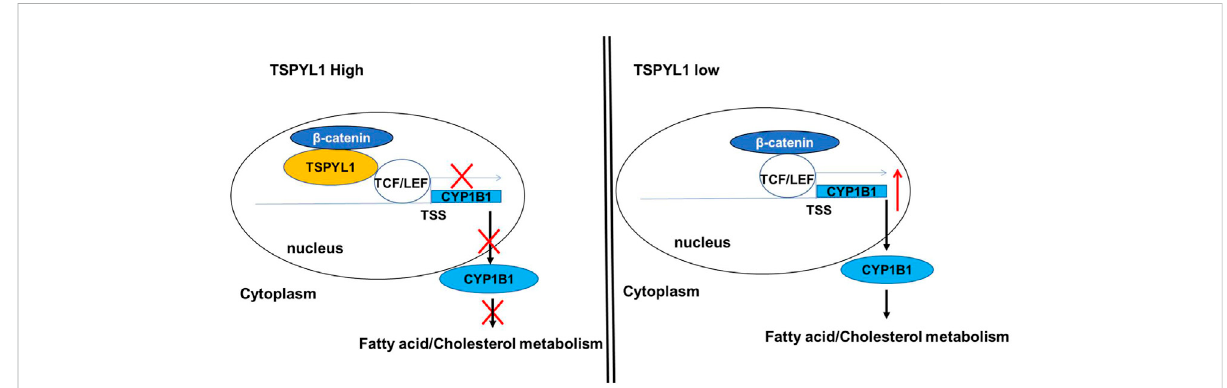
FIGURE 9 Proposed schematic model for the role of TSPYL1 in CYP1B1 transcription regulation. β -Catenin is a transcriptional activator for CYP1B1 . TSPYL1 inhibits β -catenin binding with TCF/LEF on the CYP1B1 promoter. When the TSPYL1 level decreases, β -catenin binds to TCF/LEF in the nucleus. This activates CYP1B1 transcription and interferes with fatty acid and cholesterol